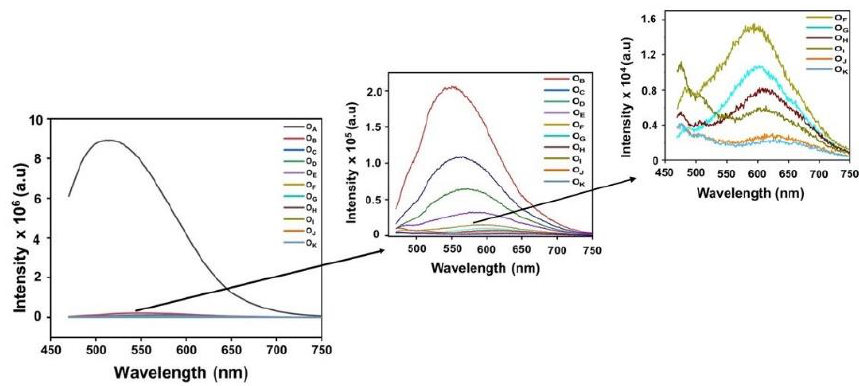
Figure 5. PL spectra of the samples for the excitation wavelength of 442 nm.